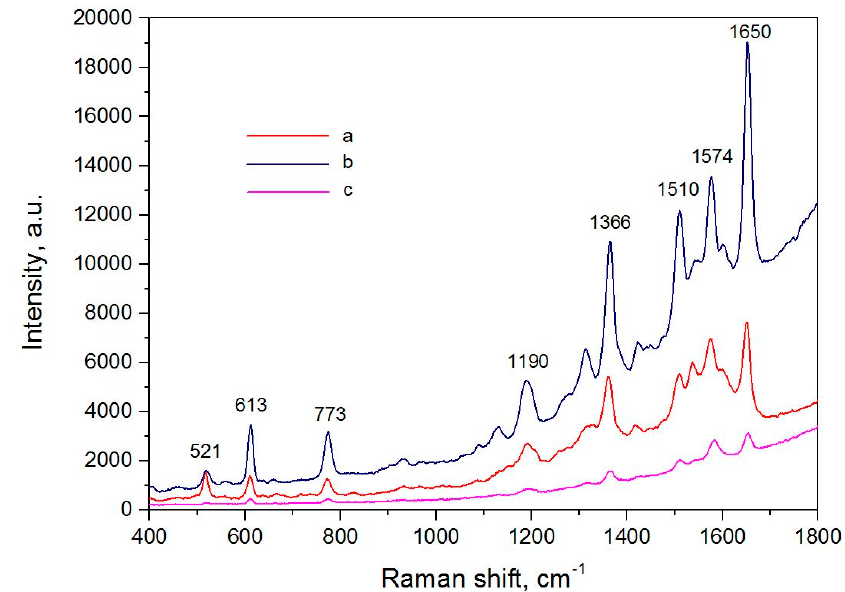
Figure 5. SERS-spectra of R6G molecules adsorbed from 10 − 6 M solution on the silvered por -Si: ( a ) Free of graphene; ( b ) covered with graphene, in the light spot; ( c ) covered with graphene, in the dark spot.